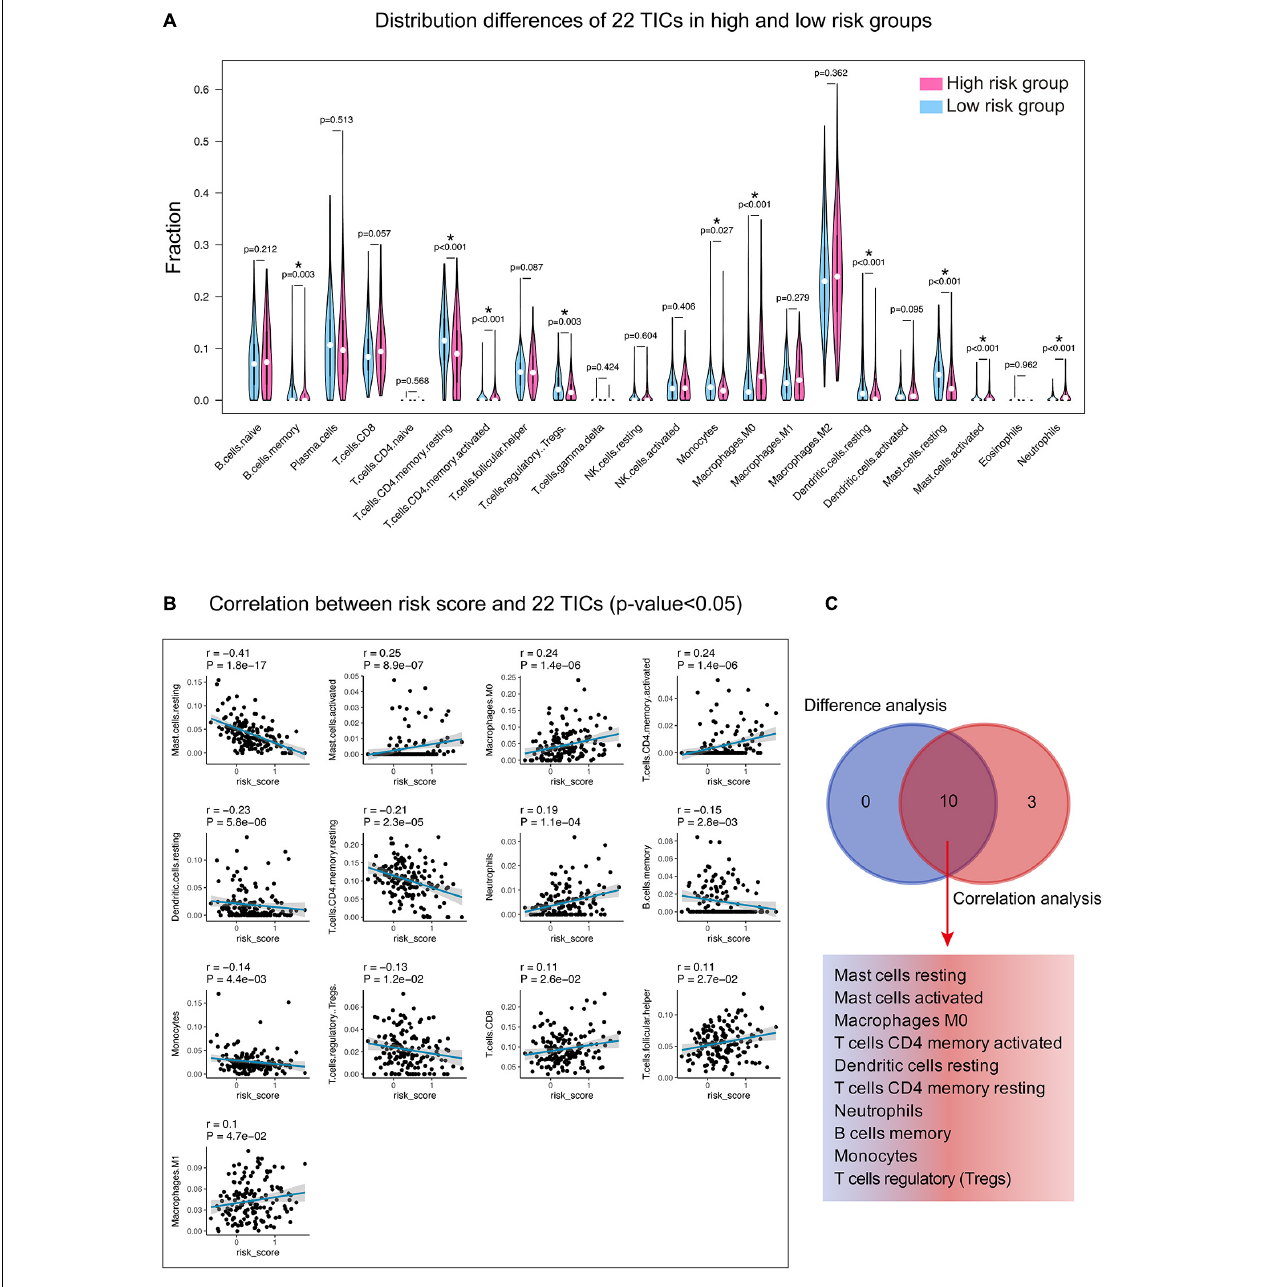
FIGURE 8 | Relationship between TICs and 15-gene signature risk score. (A) The Violin plot shows the ratio differentiation of each of 22 TICs between the high- and low-risk groups. Wilcoxon rank sum was applied for the significance test. (B) The correlations between the TICs and 15-gene signature risk score (only correlations with significance were plotted). The blue line in each graph fits a linear model that indicates the proportional trend of the TICs and the risk score. The shading around the blue line represents the 95% confidence interval. The Spearman coefficient was applied for the correlation test. (C) The Venn diagram shows that 10 TICs have a pronounced correlation with the risk score, which is determined by the results of the violin and the scatter plot. P -value < 0.05 is the cutoff. TIC, tumor-infiltrating immune cell. *, P -value <